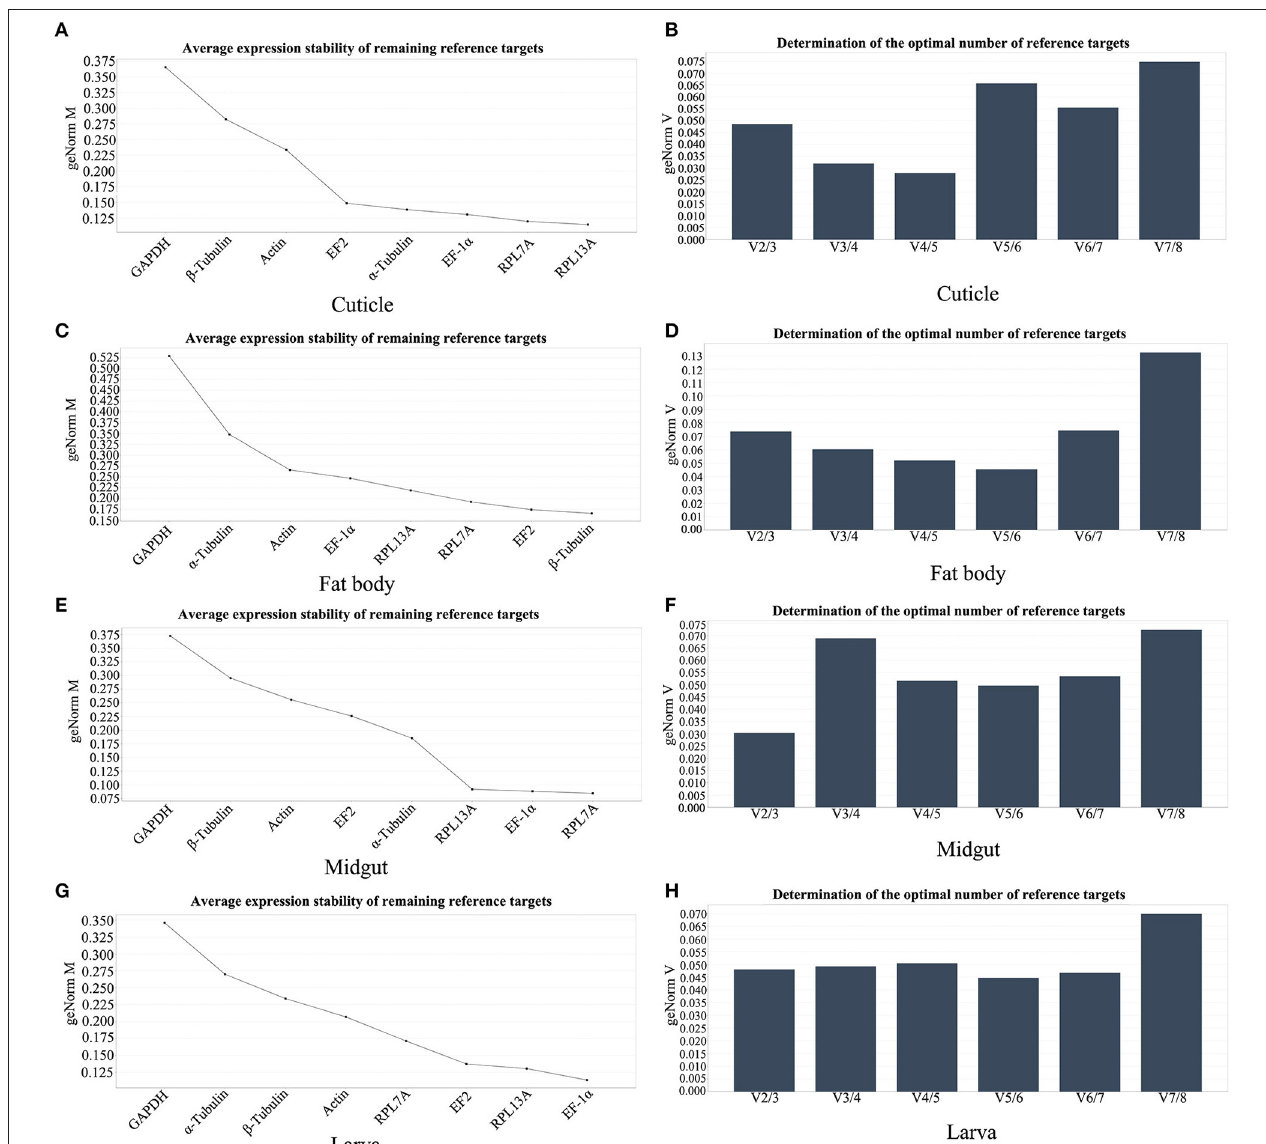
FIGURE 4 | The stability of reference genes expression and the optimal number for normalization analyzed by geNorm software. (A,C,E,G) The stability validation of reference genes expression in cuticle, fat body, midgut, and larva. (B,D,F,H) pairwise variation values in cuticle, fat body, midgut, and larva. Abbreviations were showed as in Figure 1